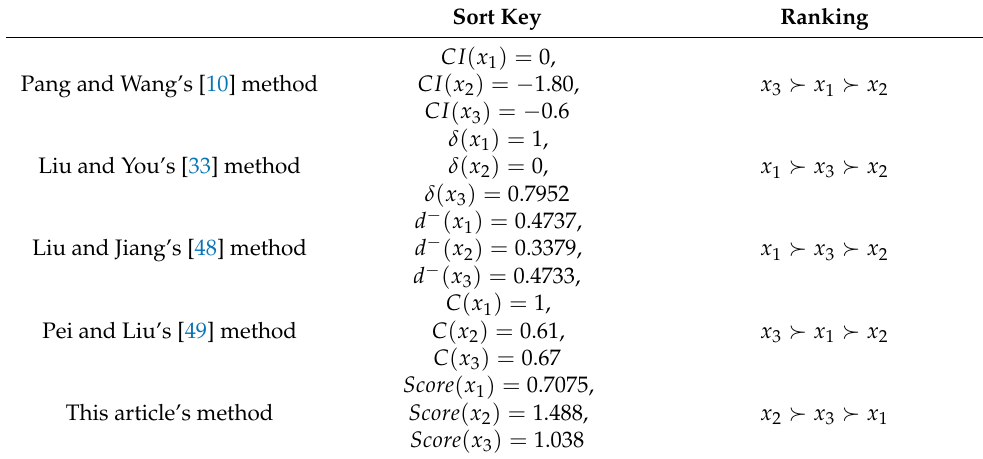
Table 8. Comparison of ranking